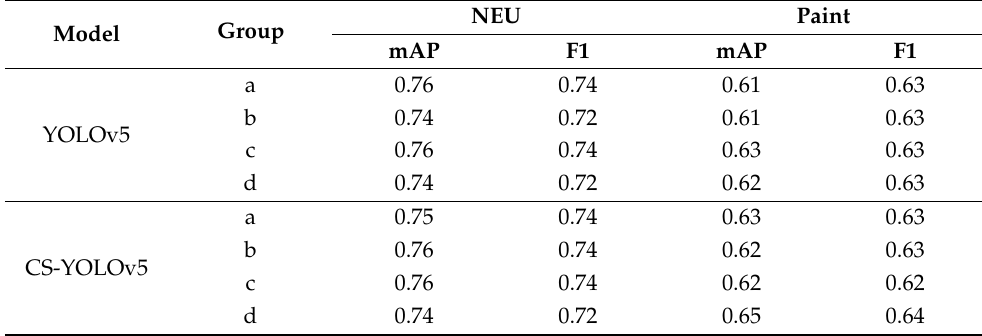
Table 2. mAP and F1-Score with Different Risk Coefficients.